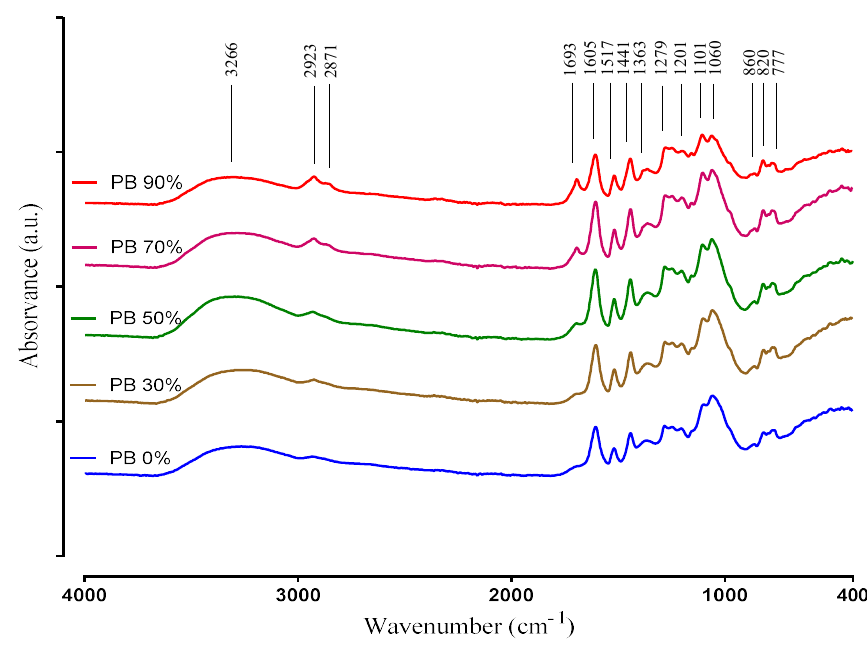
Figure 2. ATR-FTIR spectra of aqueous and hydroethanolic extracts from Pinus pinaster bark.